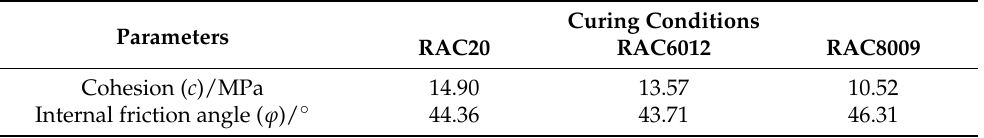
Table 5. c and ϕ of RAC under different curing